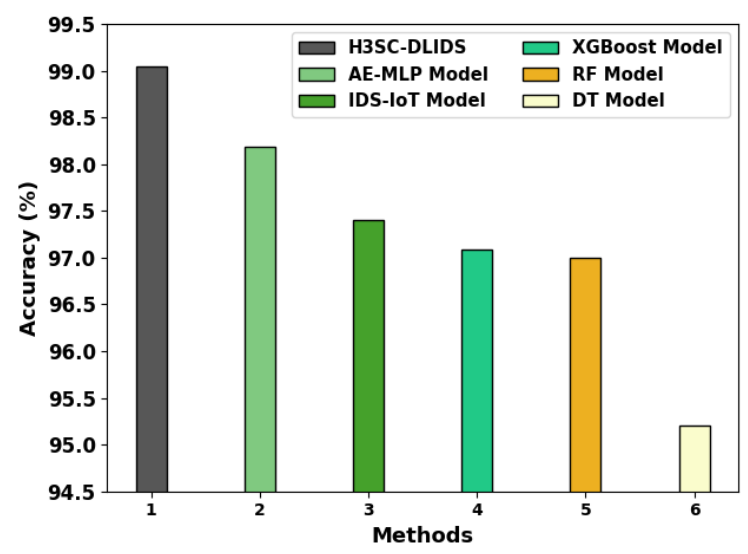
Figure 12. Comparative analysis results of the H3SC-DLIDS approach and other systems.